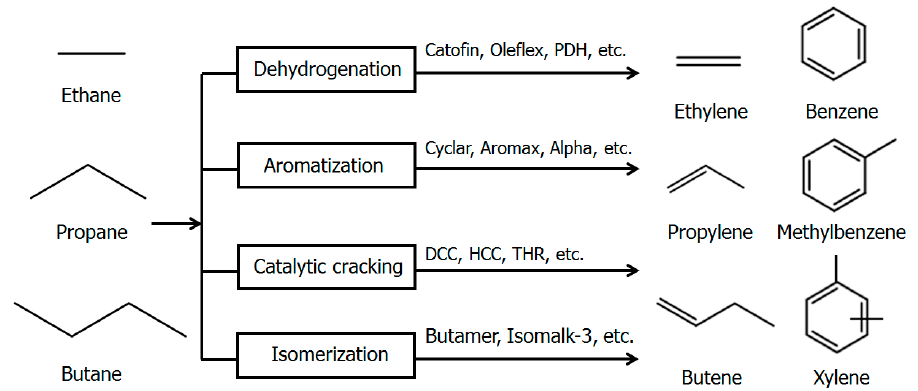
Figure 2. Schematic diagram of downstream products from catalytic conversion of light alkanes and their industrial processes.